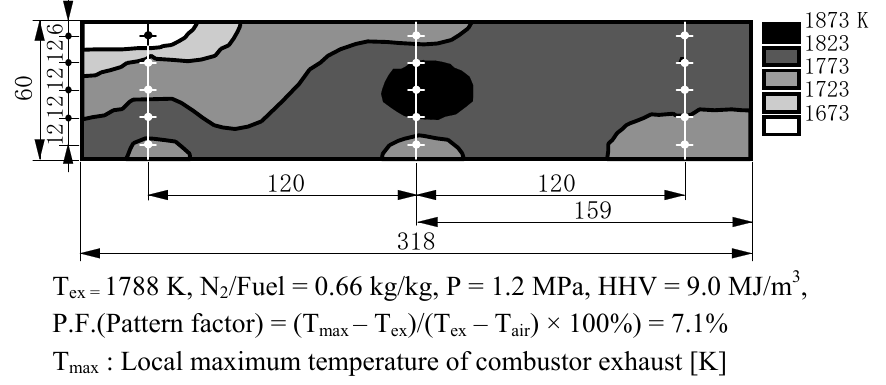
Figure 86. Combustor exhaust temperature distribution characteristics.